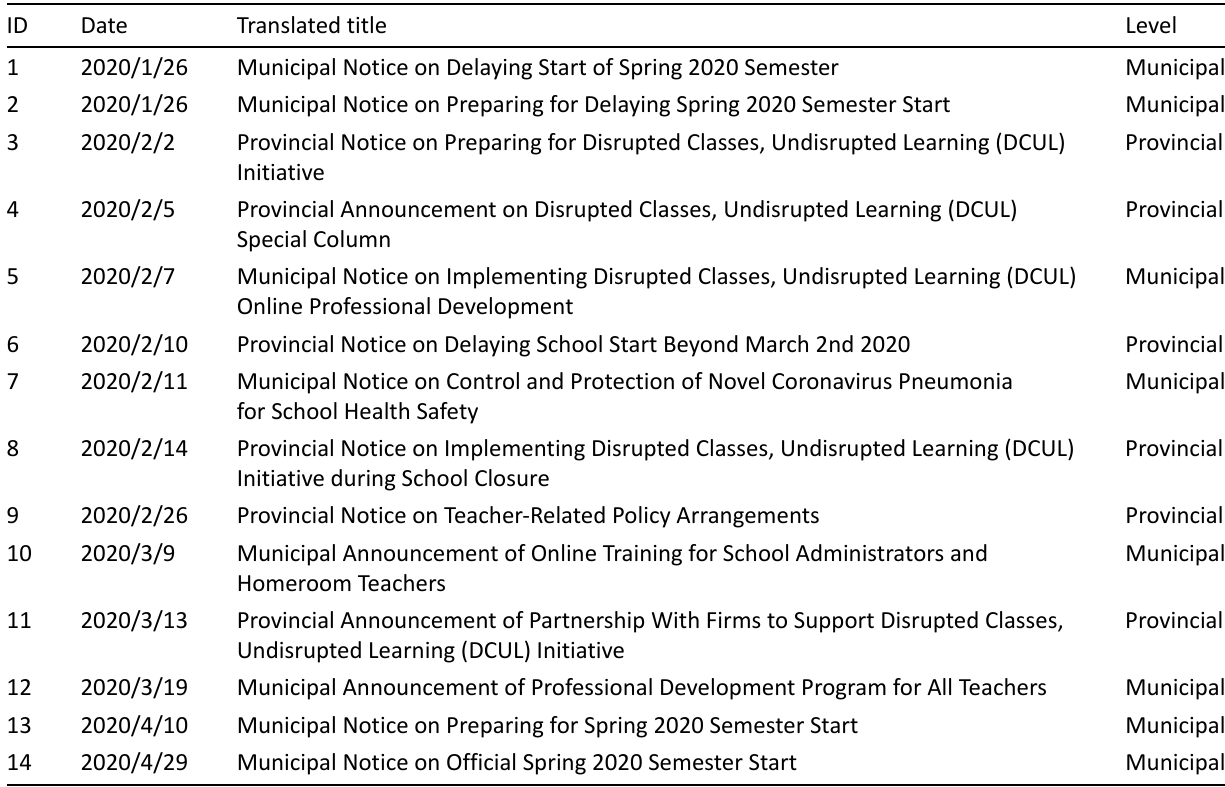
Table 1. List of provincial policy documents